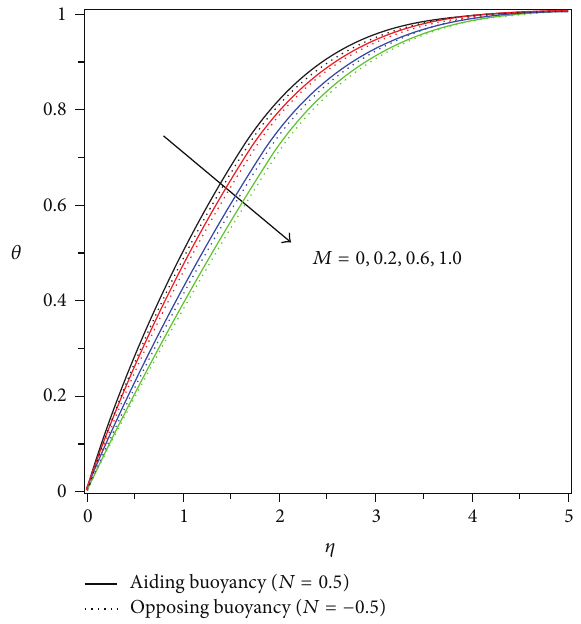
Figure 6: Temperature profile for both aiding and opposing buoy- ancy for different values of 𝑀, Df = 0.02 , Sr = 0.2 , Gr / Re = 0.1 , and Le = 1.0 .